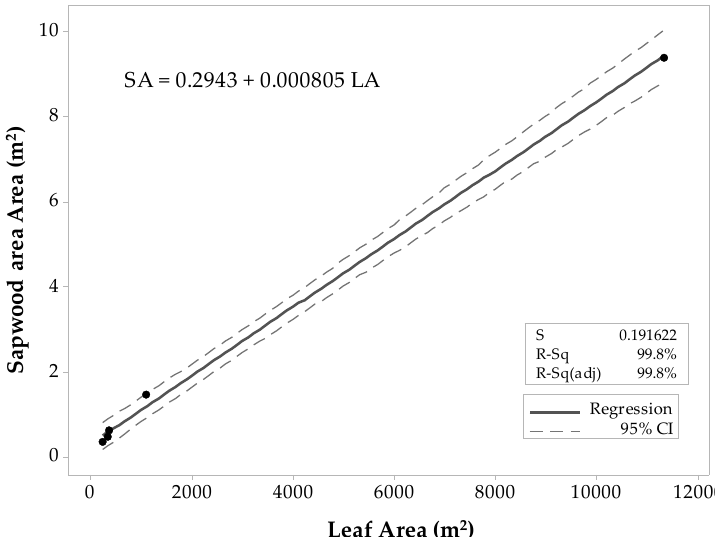
Figure 3. Fitted linear regression model for Populus tremuloides predicted SA plot in relation to its LA plot . This model includes all 60 × 60 m and 10 × 10 m stands.